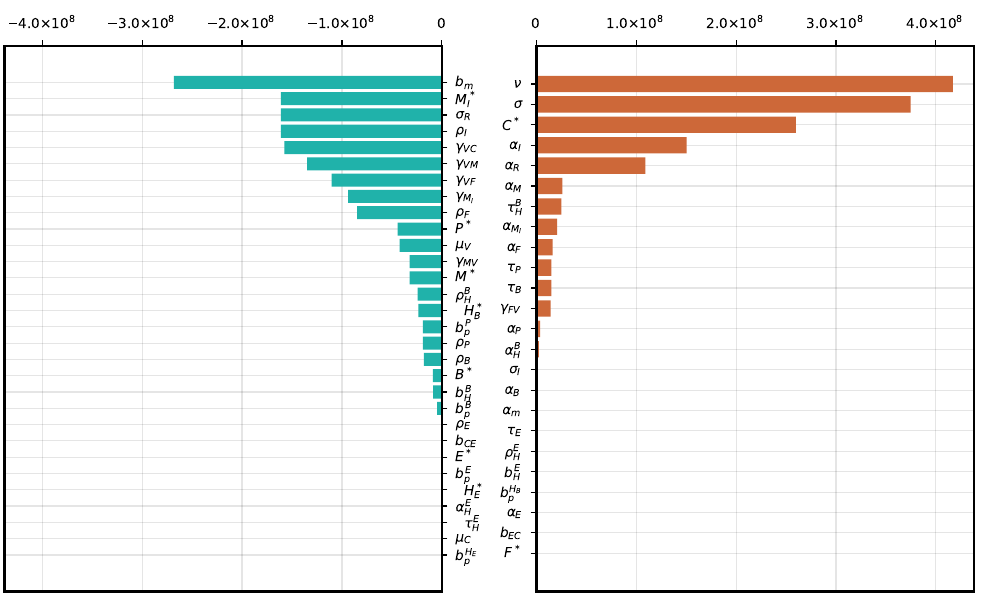
Figure 3. Local parameter variation. Normalized sensitivity indices for cumulative viral load Φ ( p ) = 1.6 × 10 8 AUC